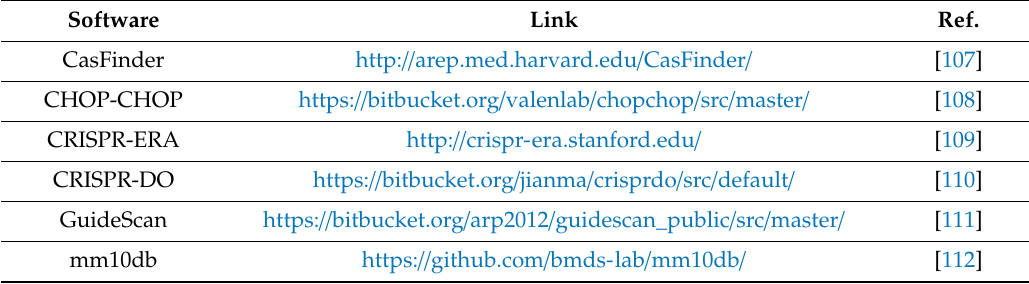
Table 3. List of on-line tools for guide RNA (gRNA)